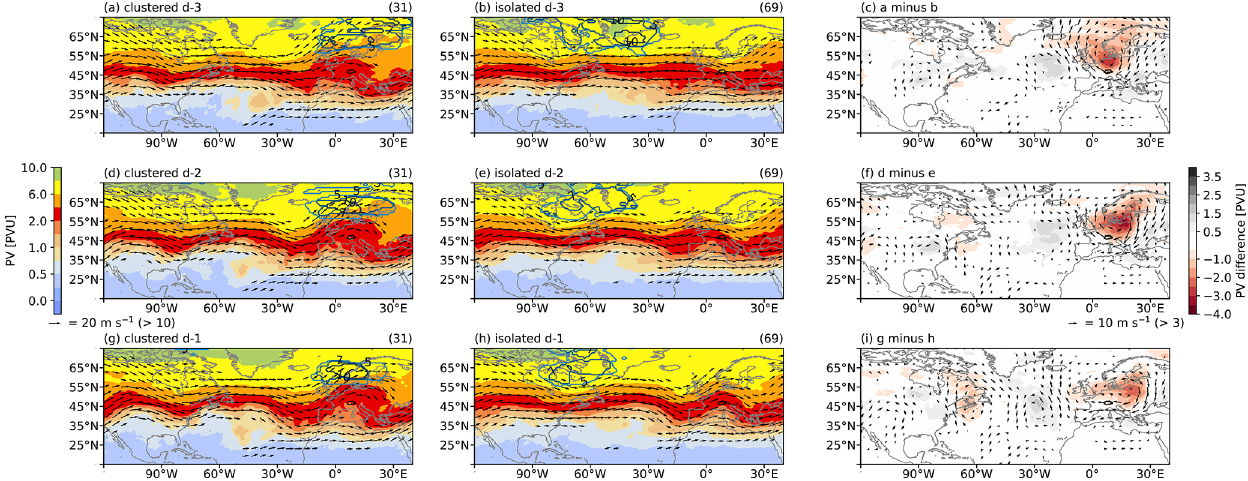
Figure 7. PV at 335K (colored contours), wind at 250hPa (vectors), and blocking frequency (contour lines) for the 3d prior to clus- tered (a, d, g) and isolated (b, e, h) hail days north of the Alps. The differences are shown in panels (c) , (f) , and (i) . See caption of Fig. 5 for details.